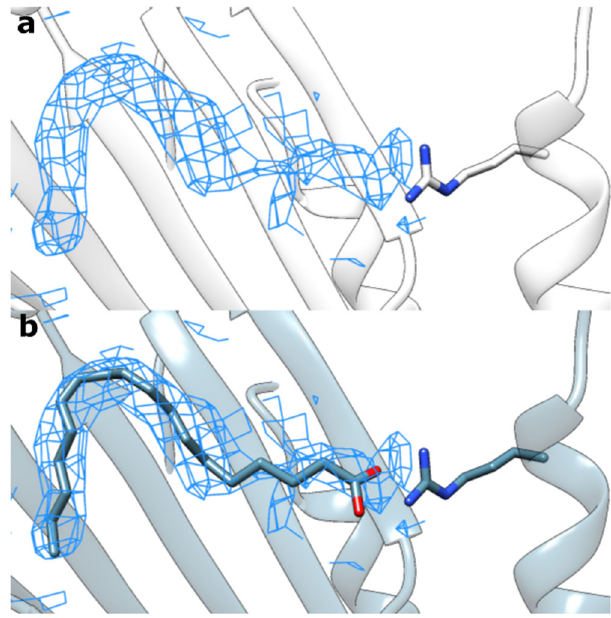
Fig. 6 | Blind modeling of linoleic acid. a Unmodeled density for linoleic acid (local resolution: 2.9Å). b Output model from density-guided docking. The model makes an anchoring electrostatic interaction with a nearby arginine residue and models the tail strain-free into the